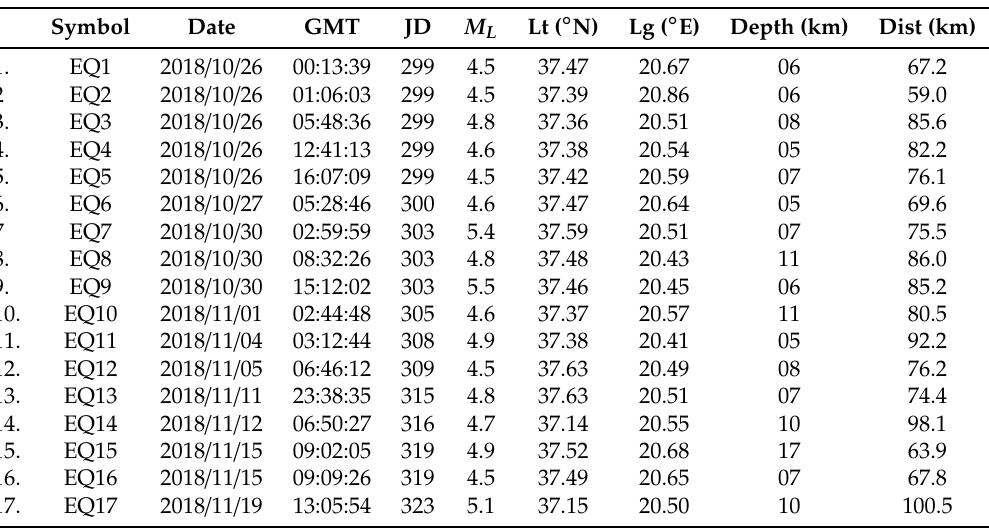
Table 1. Earthquakes included in the present study in chronological sequence. Actual dates and corresponding Julian Days (JD) of 2009 are also given. Abbreviations: M L : Local Magnitude, Lt: Latitude, Lg: Longitude, Depth: Epicentral depth, Dist: Distance of the earthquake epicenter from the Kardamas station. All data, except symbol and JD, are retrieved by